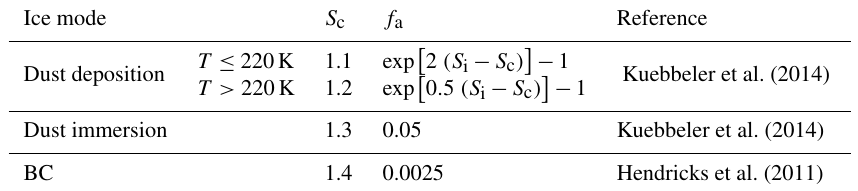
Table 1. Ice nucleation properties assumed for the different modes of heterogeneous ice formation in the cirrus scheme: ice active fraction ( f a ) and critical supersaturation ( S c ). S i is the ice